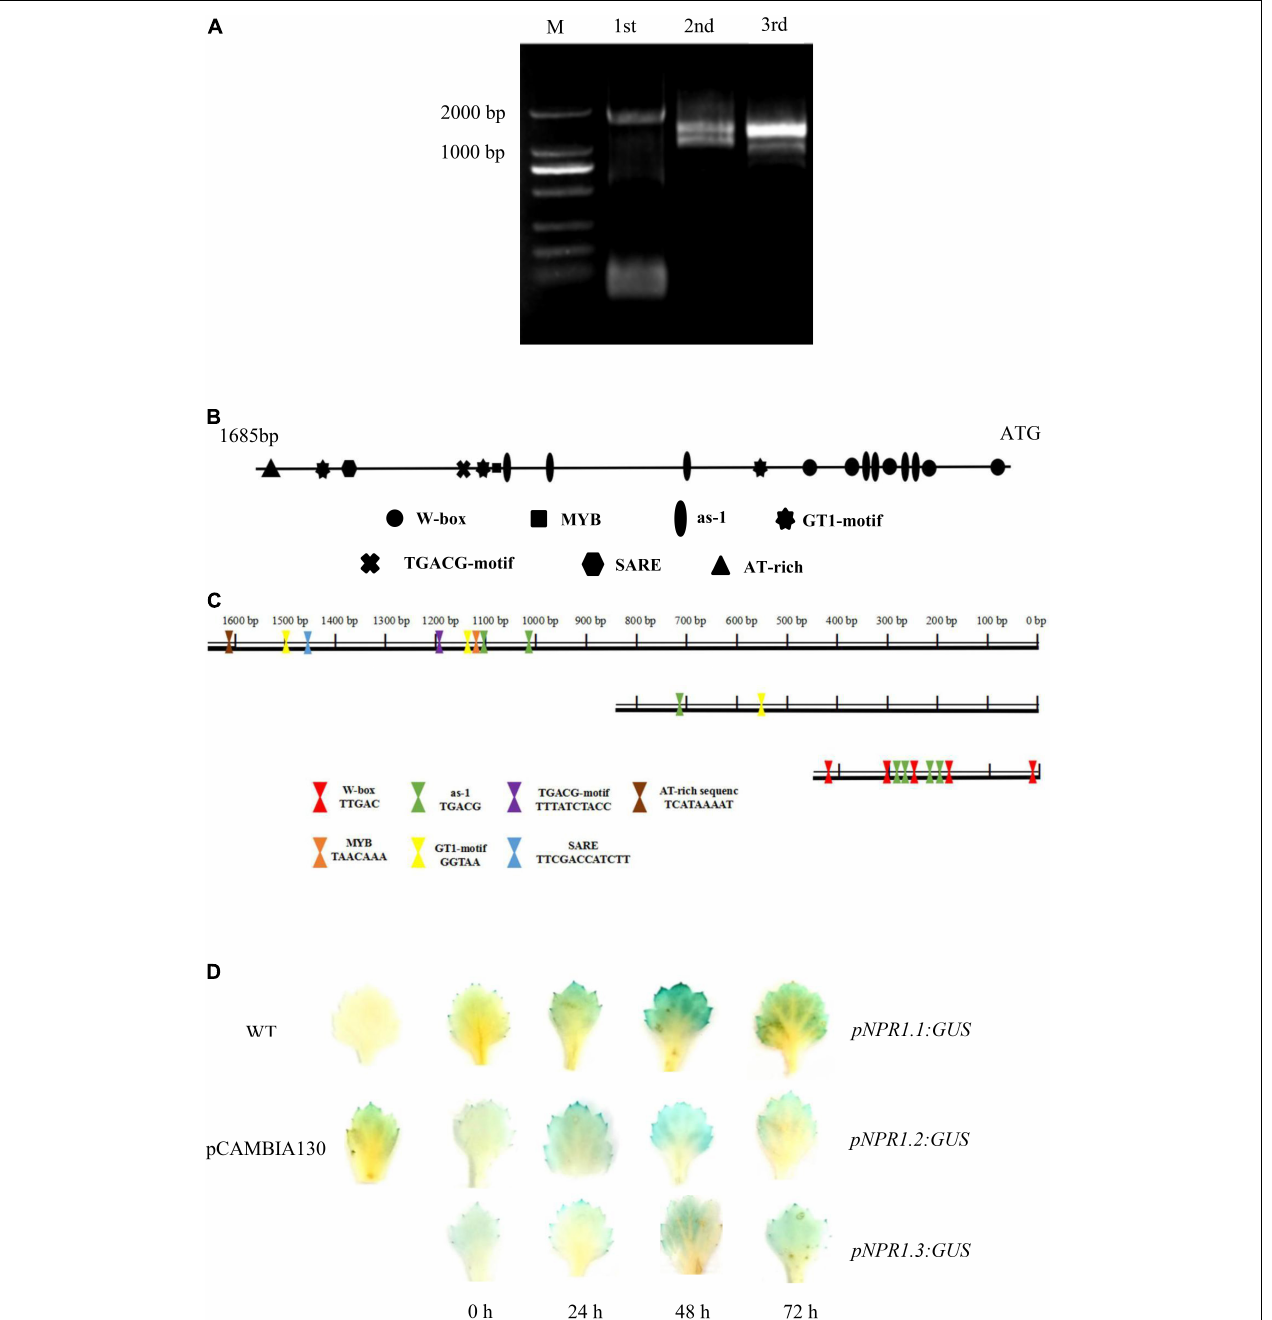
FIGURE 6 | Analysis of the CmNPR1 promoter. (A) Amplification products of the CmNPR1 promoter obtained by hiTAIL-PCR: M, Marker; 1st: First round PCR; 2nd: Second round PCR; 3rd: Third round PCR. (B) Analysis of cis -elements in the CmNPR1 promoter. (C) Diagram of the pNPR1.1, pNPR1.2, and pNPR1.3 vectors. (D) GUS histochemical staining to analyze expression of the CmNPR1 promoter in response to the pathogen. WT, wild-type negative control; pCAMBIA1301, positive control.